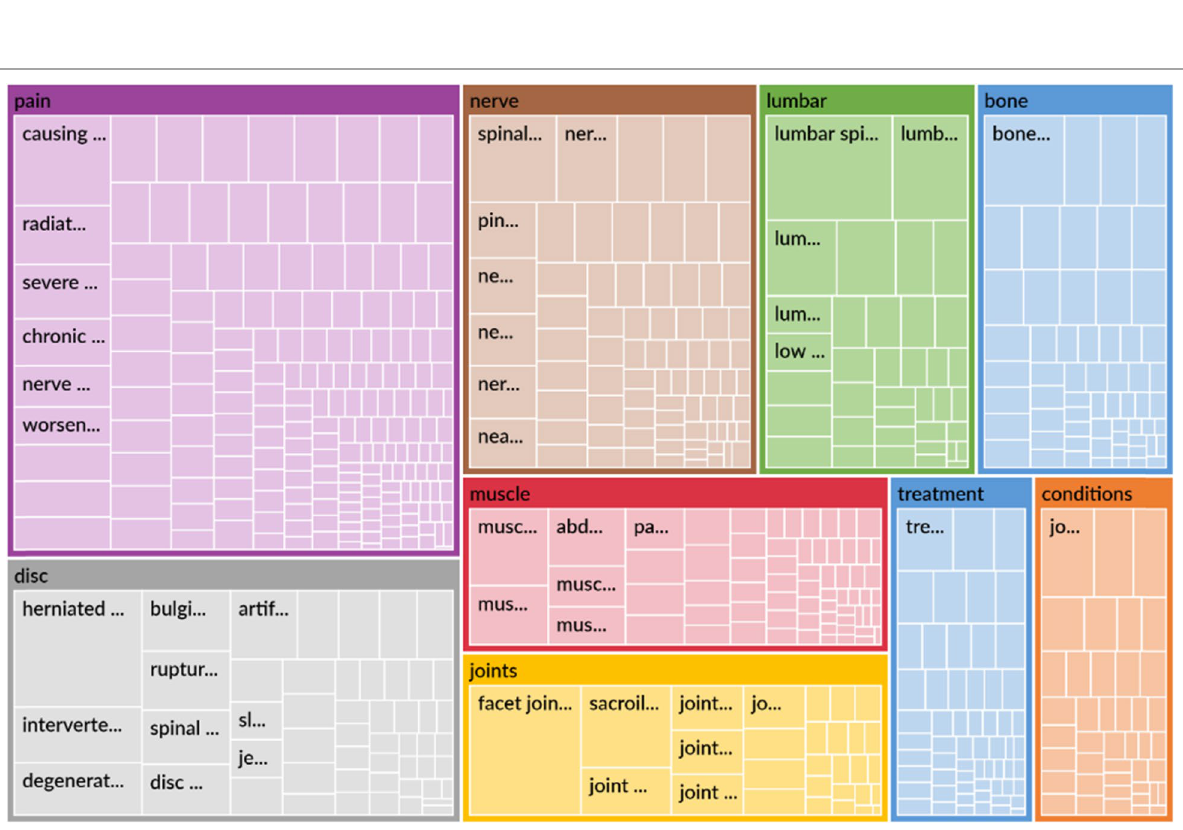
Fig. 2 Major topics discussed on the